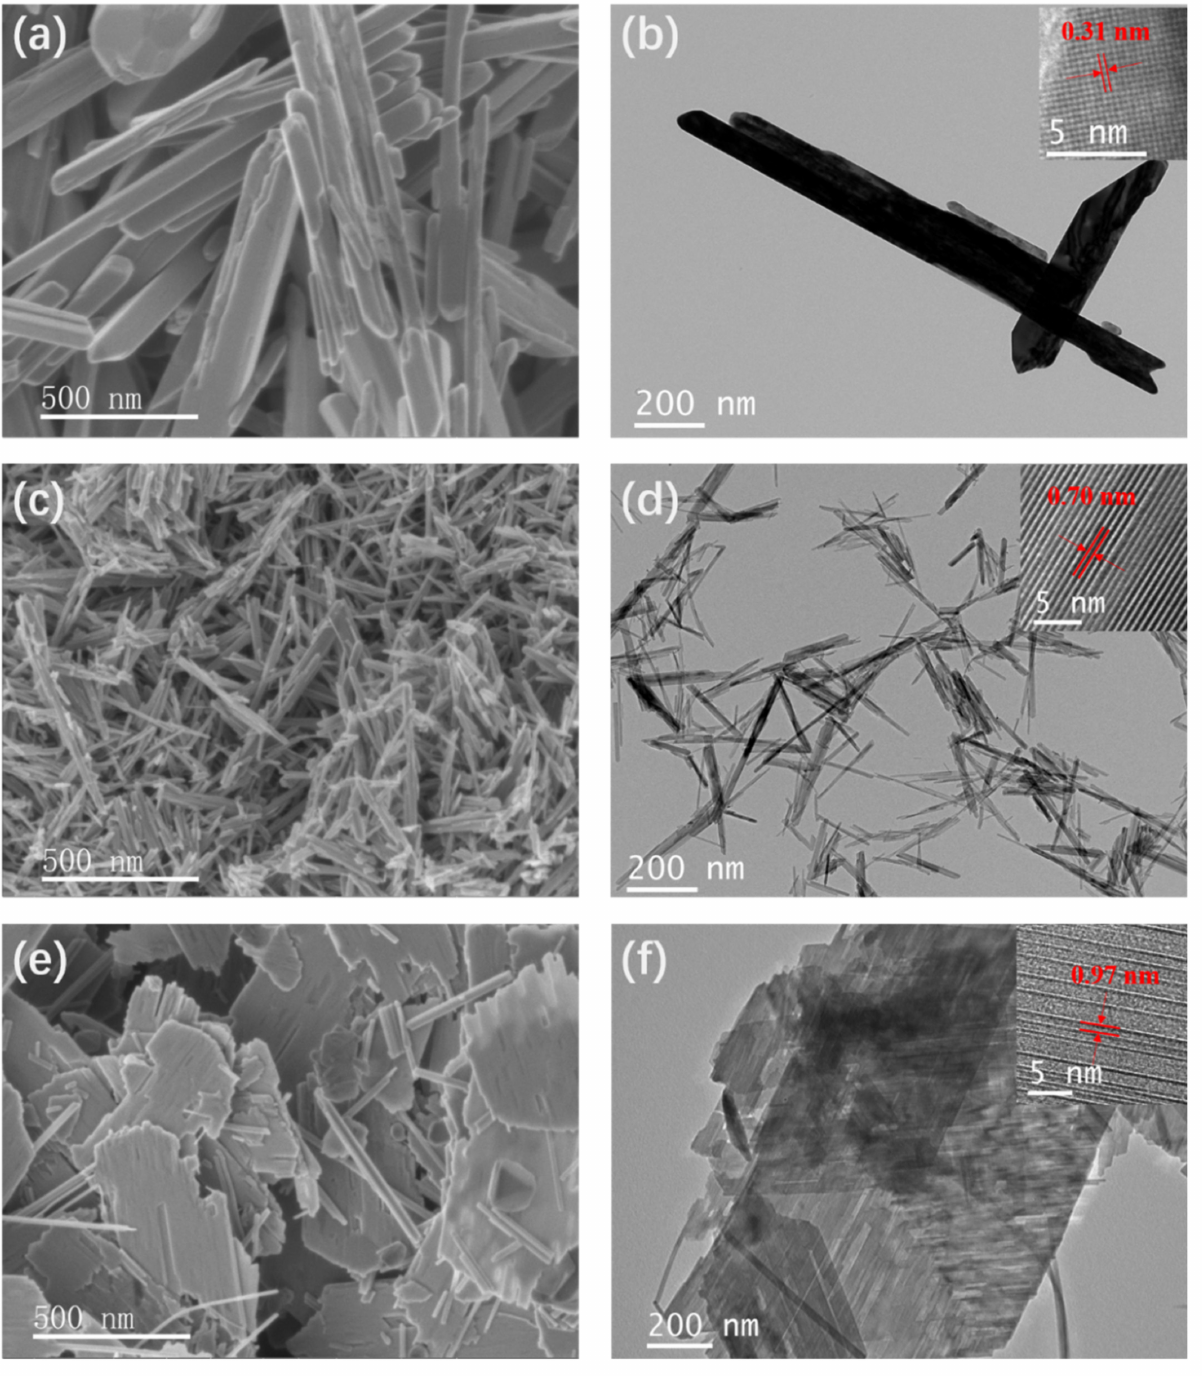
Figure 2. Morphological characterization: ( a , c , e ) SEM images of β -MnO 2 , α -MnO 2 and t- MnO 2 , respectively; ( b , d , f ) TEM images of β -MnO 2 , α -MnO 2 and t-MnO 2 , respectively (Insert: HRTEM